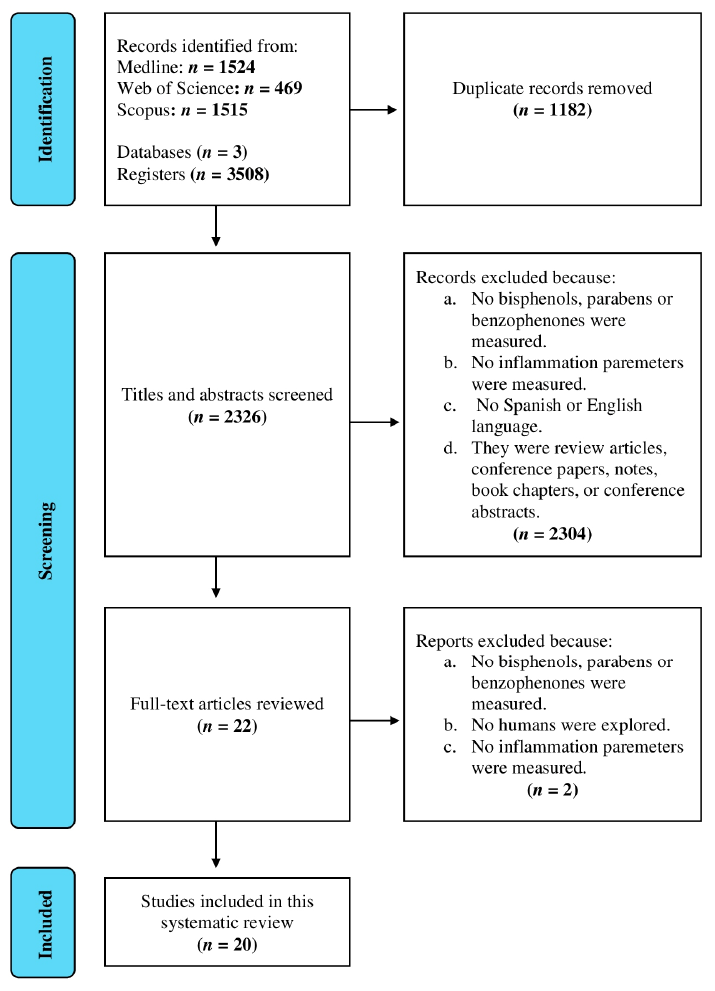
Figure 1. PRISMA flow chart for systematic review.